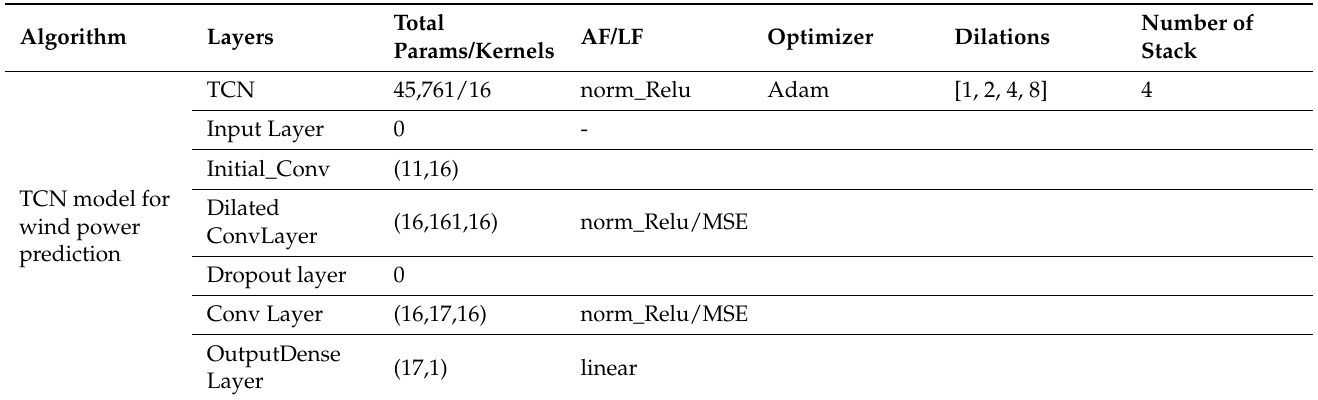
Table 7. Selected optimal parameters of the TCN